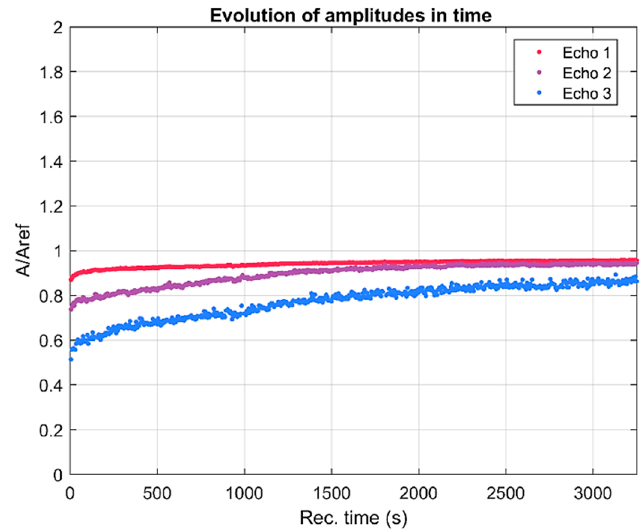
Figure 1. Relative amplitudes evolution vs. the recording moments.